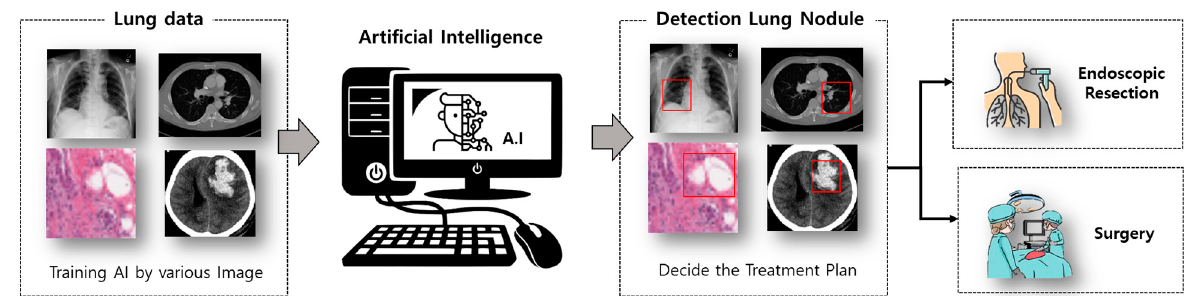
Figure 1. Image analysis and CAD system using deep learning.